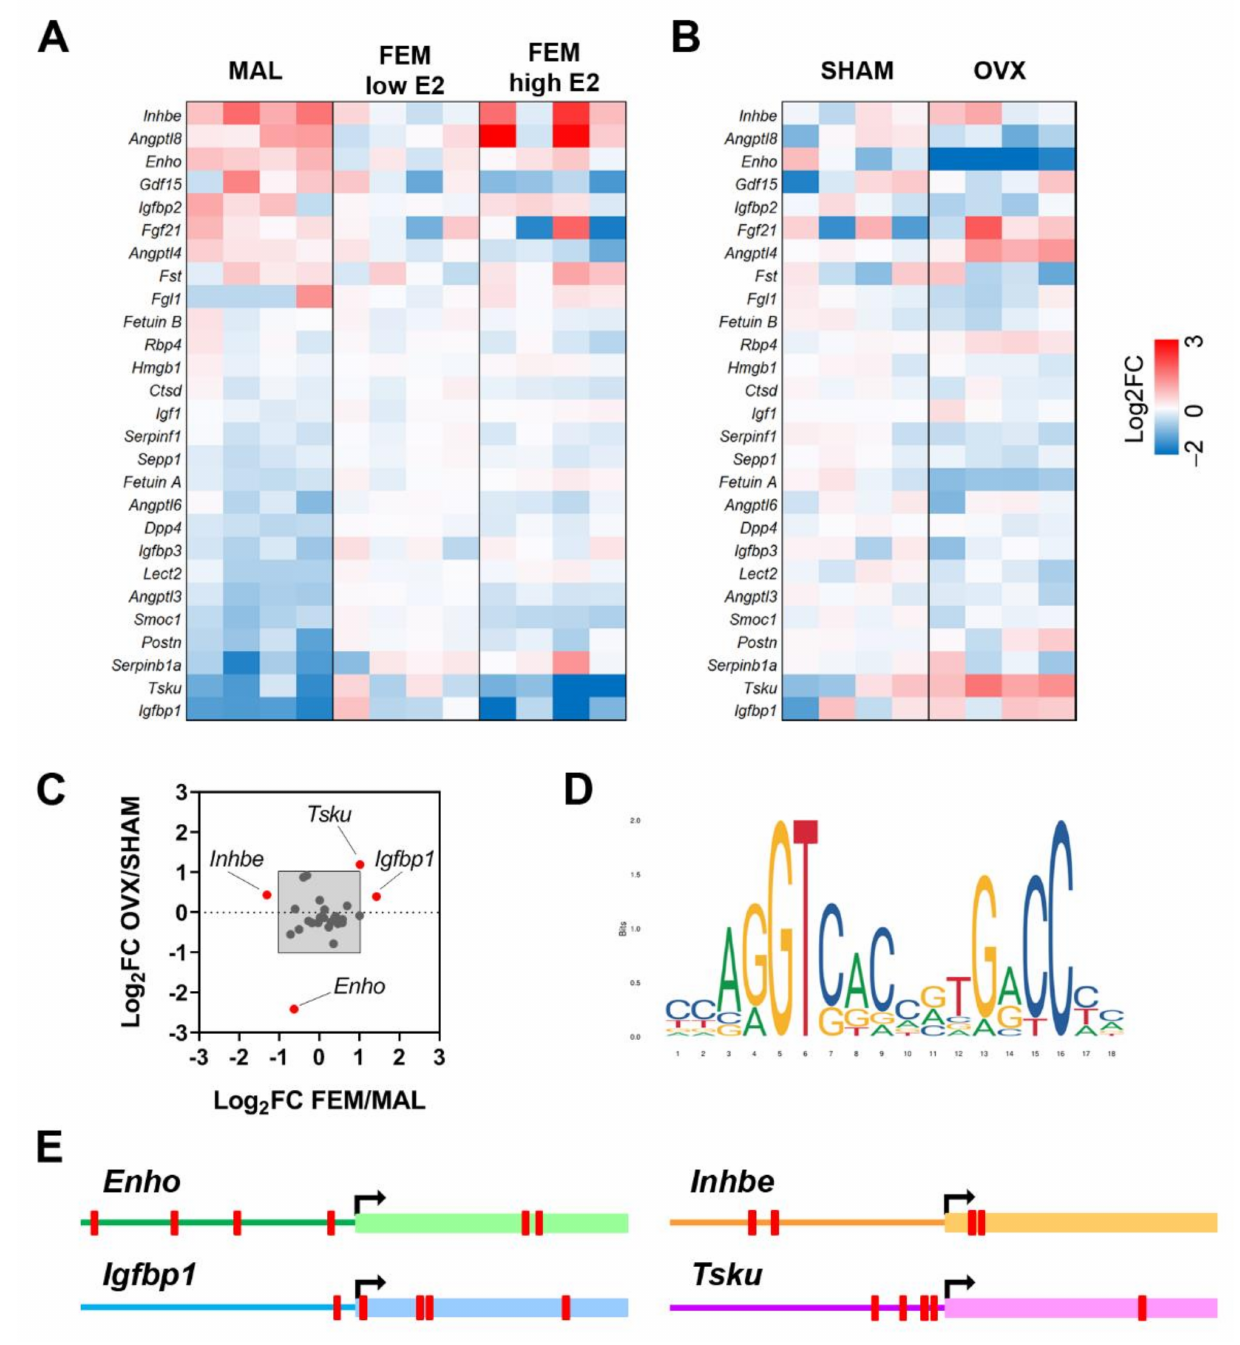
Figure 1. Sex and estrogen levels affect hepatokine mRNA levels in the liver of mice under phys- iological conditions. ( A , B ) Heatmaps reporting as Log 2 fold change (FC) the mRNA levels of the most relevant hepatokines known to be involved in NAFLD from RNA-Seq analysis performed in the livers of males (MAL) and females (FEM) at low and high levels of estrogens ( A ) and in the livers of sham-operated (SHAM) and ovariectomized (OVX) female mice ( B ) ( n = 4). ( C ) Cluster analysis performed by plotting the Log 2 FC of fertile females (FEM) over males (MAL) against the Log 2 FC of OVX over SHAM females. Enho, adropin; Inhbe , inhibin subunit beta E; Igfbp1 , insulin like growth factor binding protein 1; Tsku, tsukushi. ( D , E ) Estrogen-responsive elements (EREs) identified in the region − /+1000 around TSS of Enho , Inhbe , Igfbp1 , and Tsku (EREs are shown as red